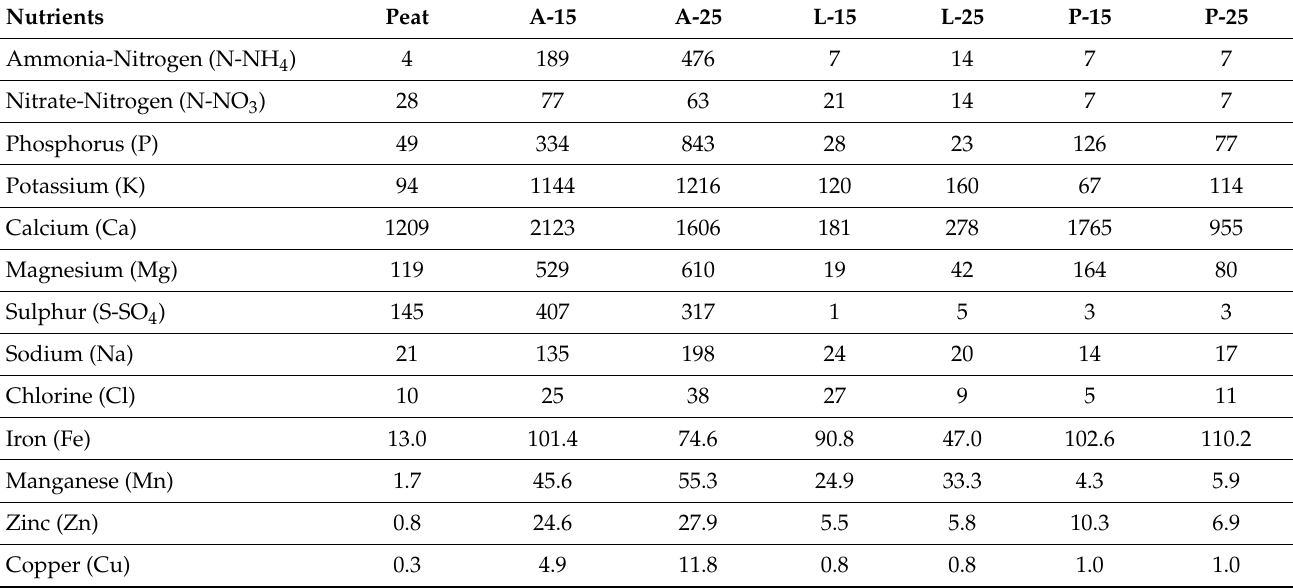
Table 1. Macro- and micronutrient concentrations (mg · L − 1 ) of different substrates used in the study.